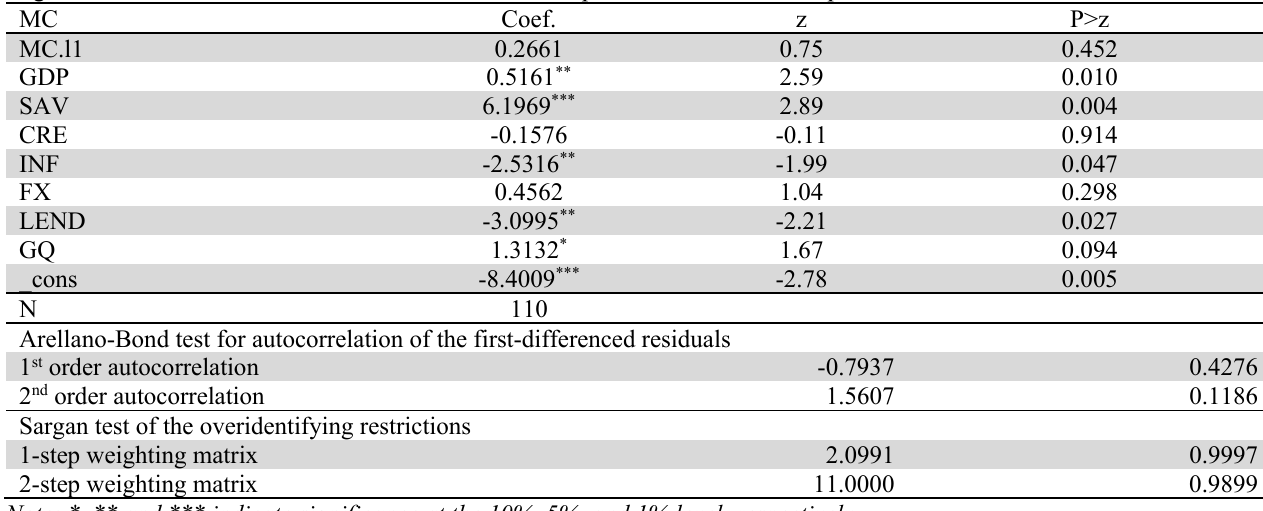
Regression results of institutional and macroeconomic impacts on stock market capitalization at EAP